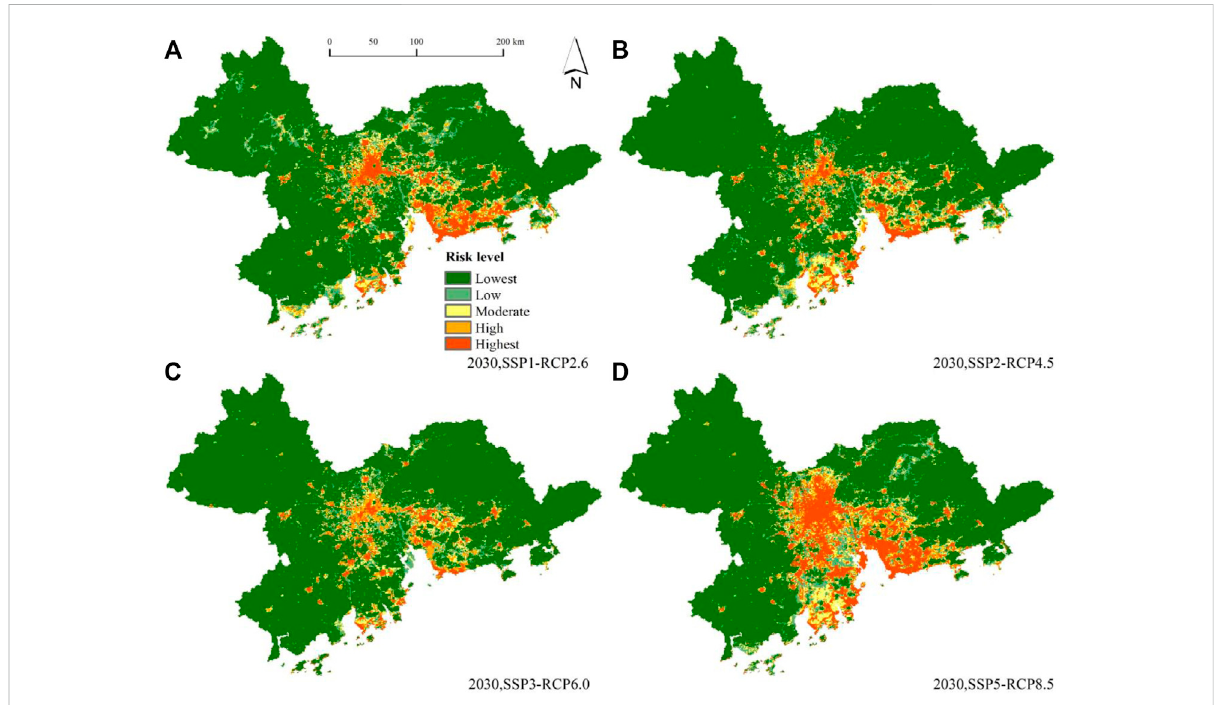
FIGURE 7 Spatial distribution of future fl ooding risk over the PRD under four scenarios in 2030.